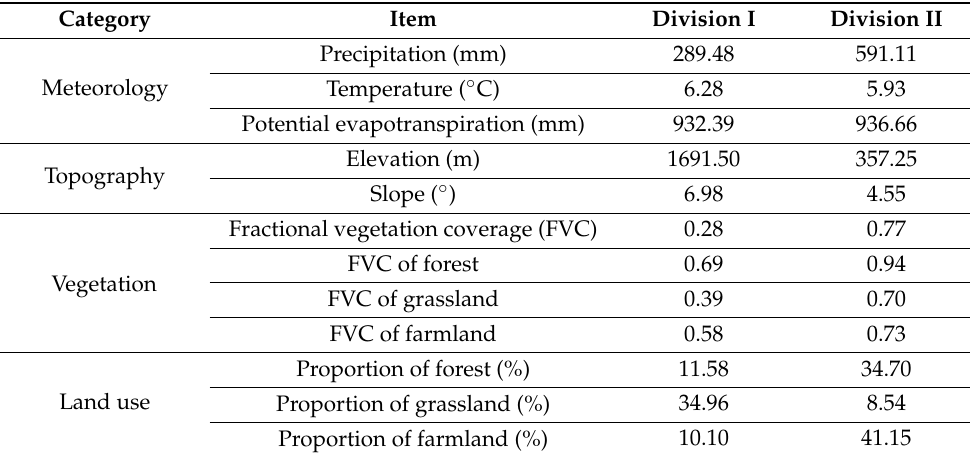
Figure 3. Classification of the relationship between WEPSs and environmental factors (GCS: WGS84). Table 1. Characteristics of environmental factors in different divisions.